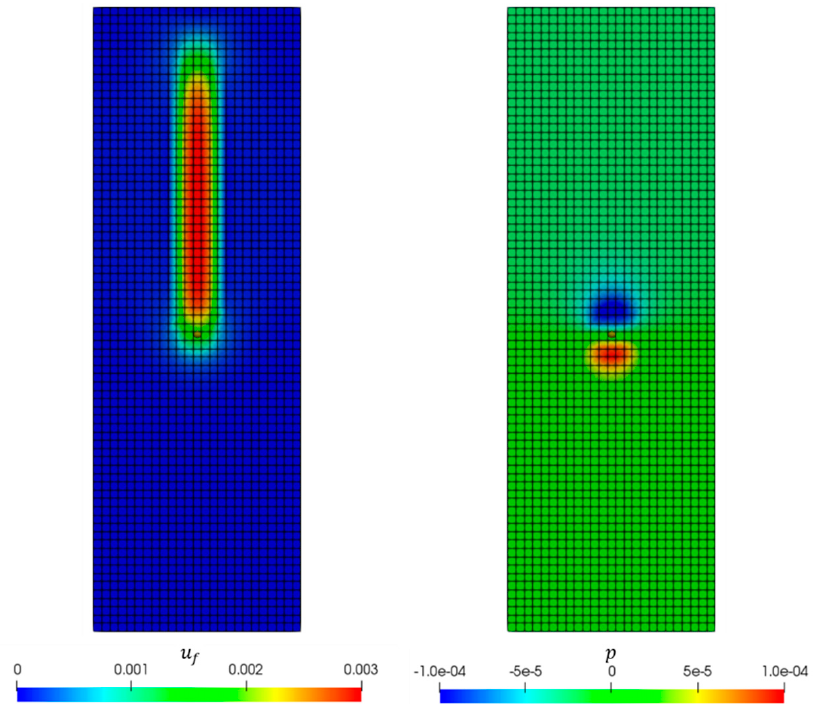
Figure 5. Velocity ( u f ) and pressure ( p ) contours ( ∆ x / d p = 1).